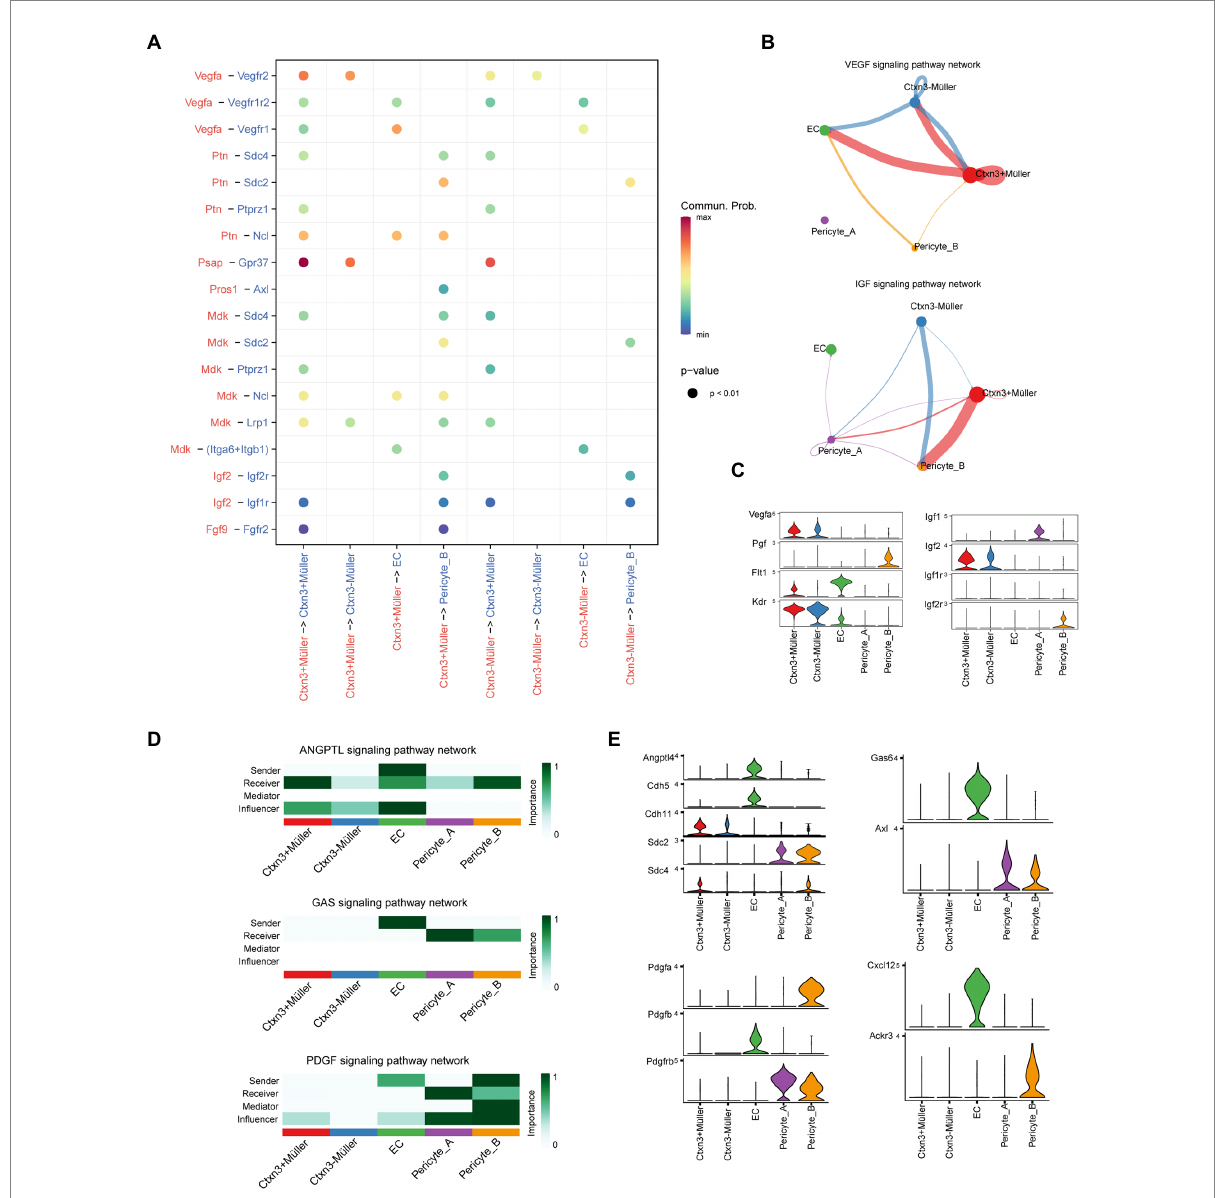
FIGURE 4 Communication network between Müller cells and the iBRB. (A) Comparison of the significant ligand–receptor pairs. The color indicates the value of communication probability, and the point size indicates the p-value. Ligands and signal senders are marked in red, while receptors and receivers of signals are marked in blue. (B) VEGF and IGF signaling pathway networks among Müller cells, ECs, and pericytes. The thickness of the line represents the strength of the communication signal. (C) Violin diagram shows the expression of genes of ligand–receptor pairs in the VEGF and IGF signaling pathway network. (D) The heatmap shows the sender, receiver, mediator, and influencer of each signaling pathway network. The color represents the strength of the communication signal. (E) Violin diagram showing the expression of genes of ligand–receptor pairs in the ANGPTL, GAS, PDGF, and CXCL signaling pathway